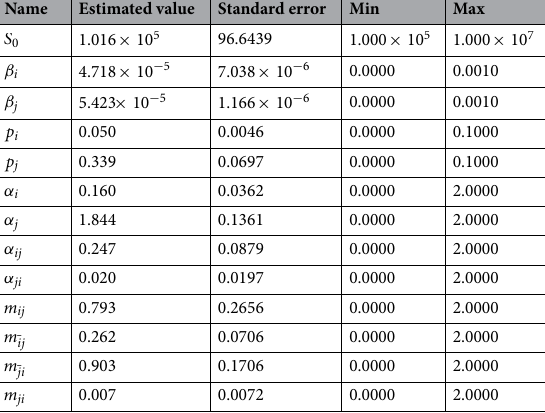
Table 5. Parameter results of two public hot events in Table 3.